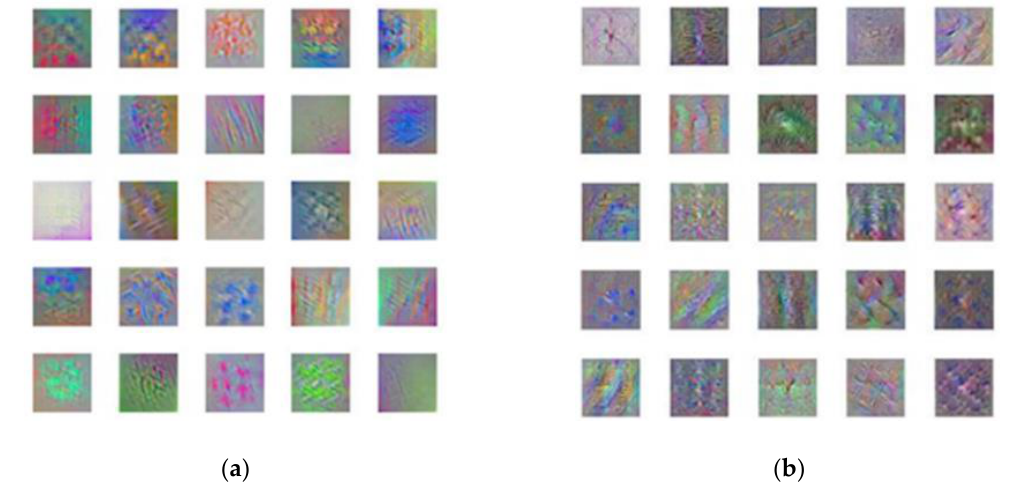
Figure 14. Visualization of crack features in the ( a ) second and ( b ) third convolutional